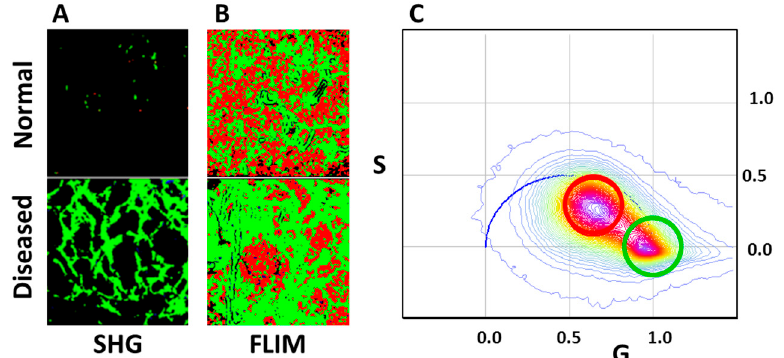
Figure 6. Second Harmonic Generation (SHG) ( A ) and FLIM ( B ) images of normal and diseased kidney samples imaged with the DIVER detector. FLIM images are colored according to cursors in the phasor plot ( C ).